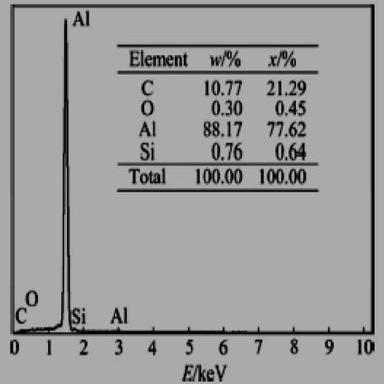
EDS spectrum of AL/Mica/SiC composite .